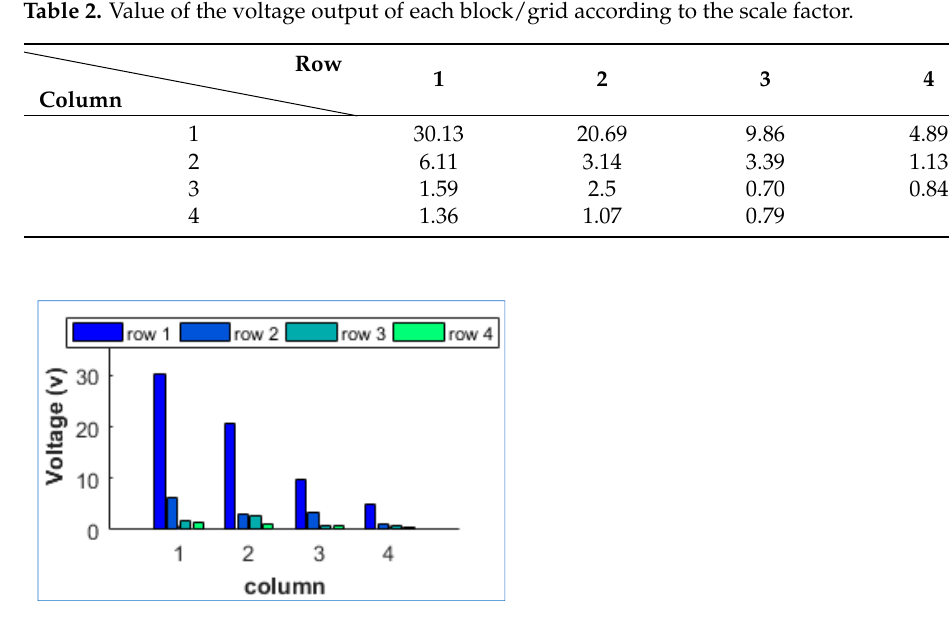
Figure 12. Comparison of the voltage output on each grid for 10 Hz.